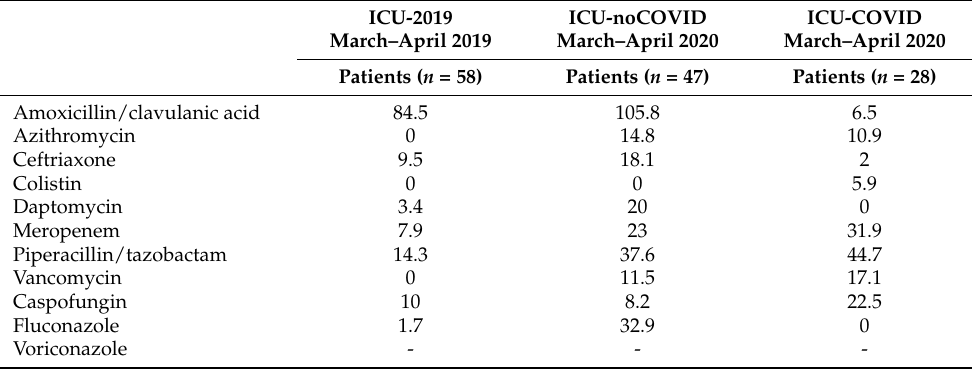
Table 5. DDD/100 bed days.